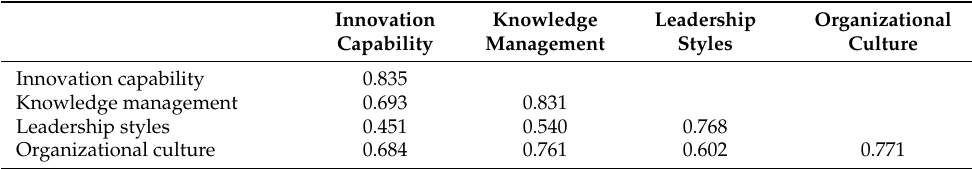
Table 4. Fornell–Larcker